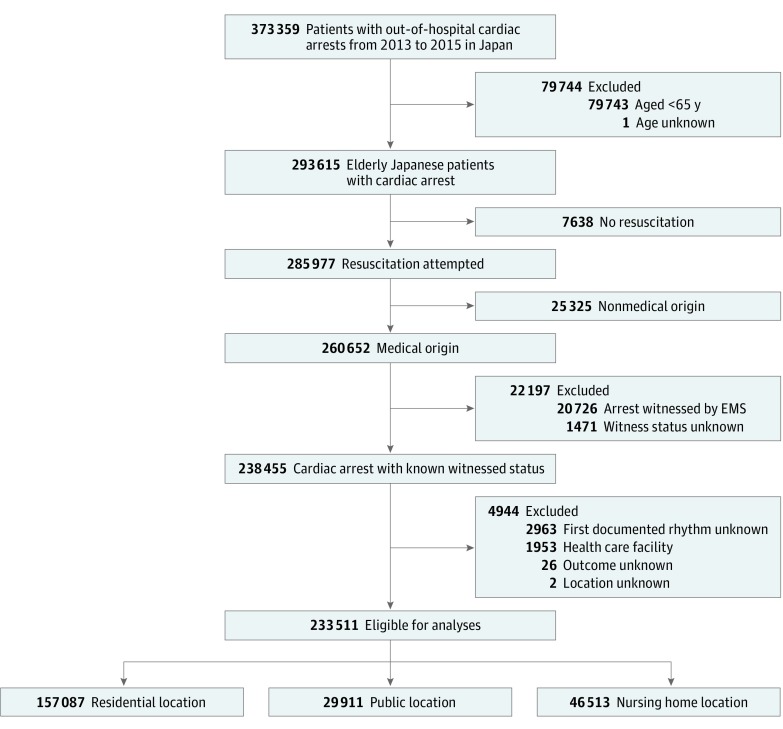
Patient Flow in This StudyEMS indicates emergency medical service.